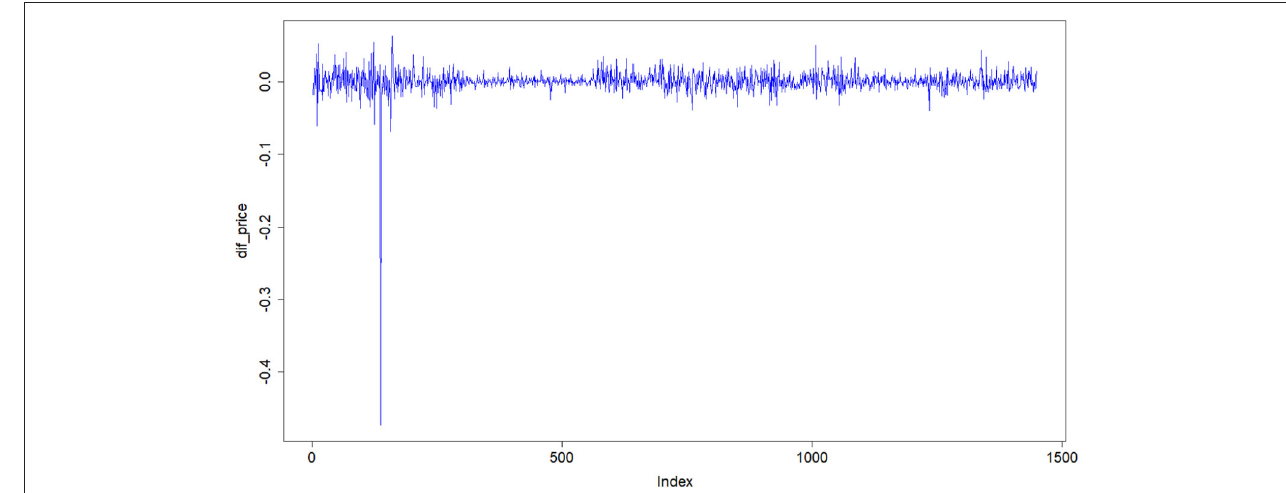
FIGURE 4 | Time series diagram after the first order difference of Ping An Insurance.